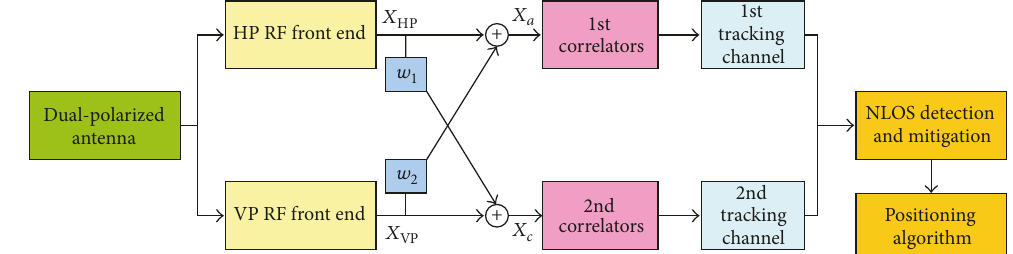
Figure 3: The axial ratio of NLOS signal when the LOS signal is RHCP.